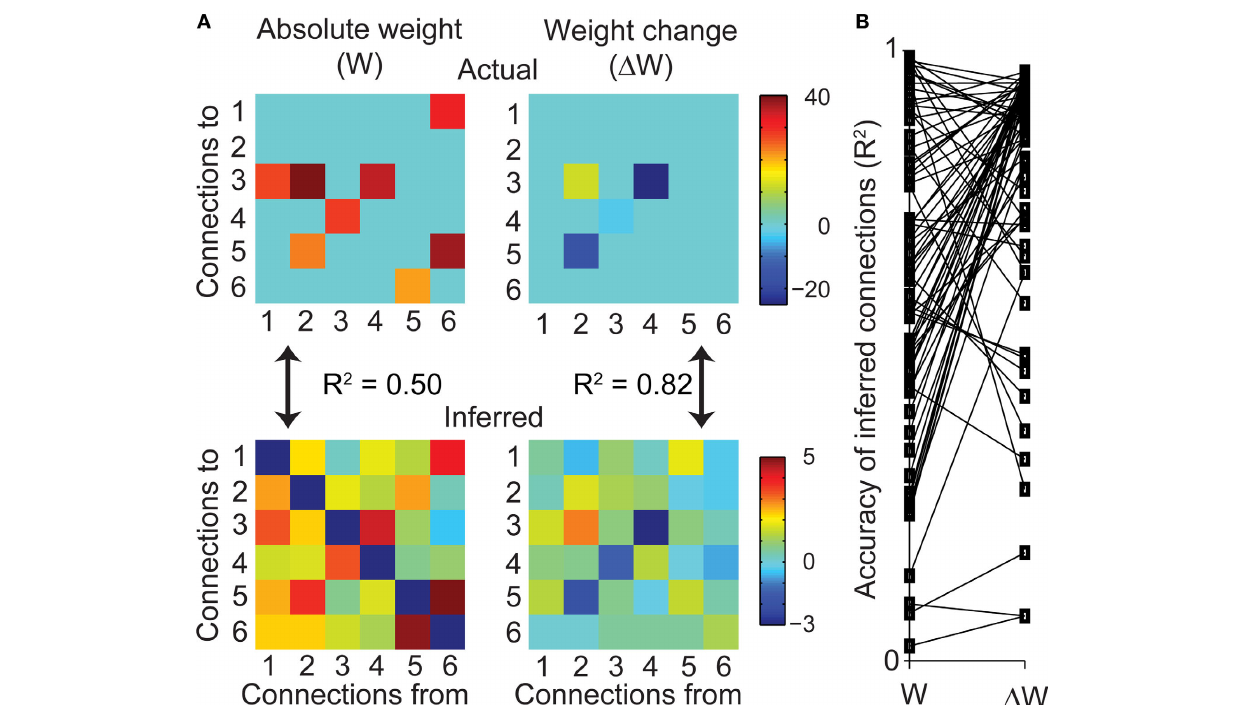
for the true network are defined through the Izhikevich model of neuron spiking, while the units of the inferred network are given by the IFC model. (B) Comparison of R 2 for inferred weights W and weight changes ∆ W for 80 experiments. Lines join the paired values resulting from a given experiment. Difference in means was highly significant ( n = 80, KS-test, p < 10 − 9